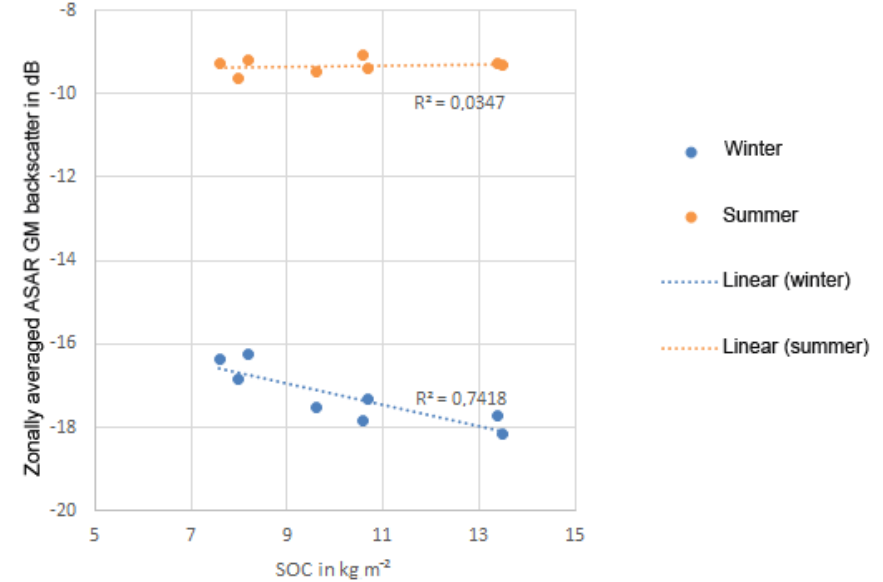
Figure 3. SOC from land cover classifications (0–30cm) versus winter and summer backscatter from ENVISAT ASAR GM for Kytalyk.